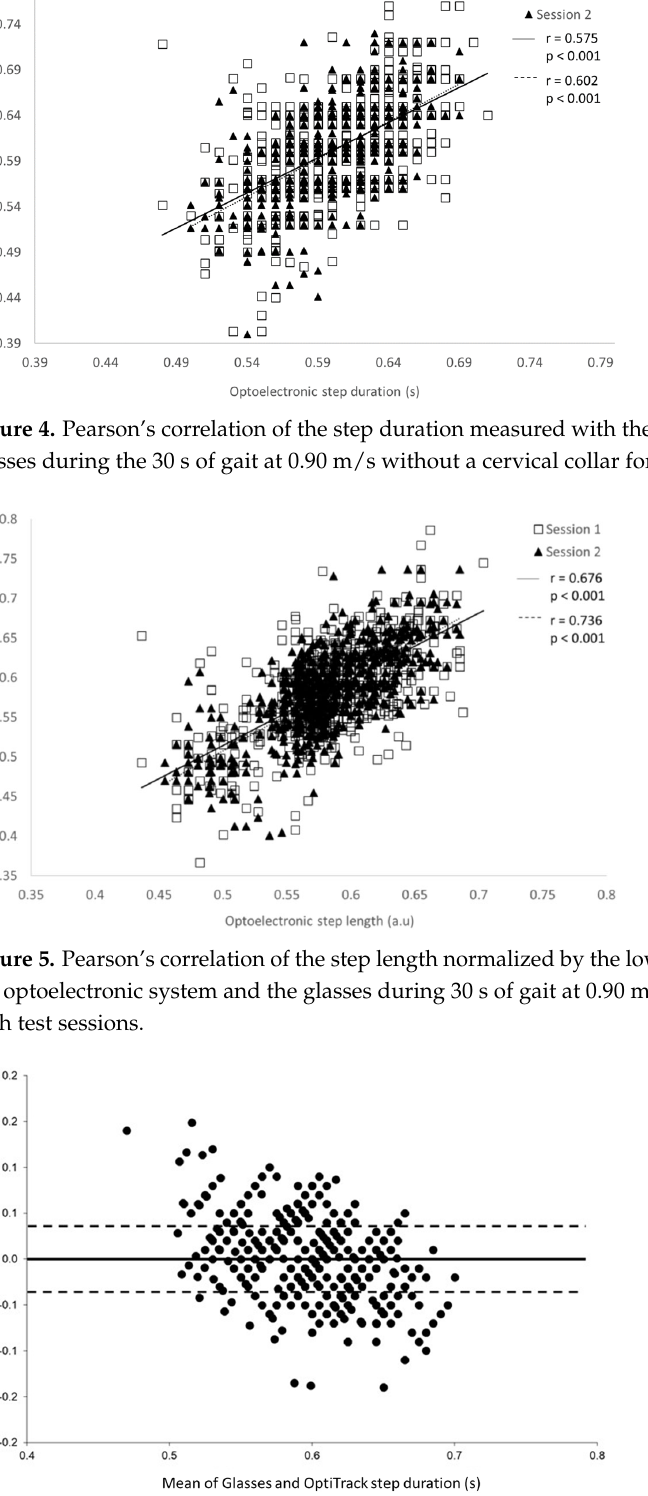
Figure 6. Bland-Altman plots of the step duration recorded without a cervical collar during the Figure 6. Bland ‐ Altman plots of the step duration recorded without a cervical collar during the Figure 6. Bland ‐ Altman plots of the step duration recorded without a cervical collar during the moderate speed condition (i.e., 0.90 m/s) for both testing sessions showing the differences between moderate speed condition (i.e., 0.90 m/s) for both testing sessions showing the differences between Figure 6. Bland ‐ Altman plots of the step duration recorded without a cervical collar during the moderate speed condition (i.e., 0.90 m/s) for both testing sessions showing the differences between the glasses and OptiTrack against the mean of the two systems. The solid horizontal line represents the glasses and OptiTrack against the mean of the two systems. The solid horizontal line represents moderate speed condition (i.e., 0.90 m/s) for both testing sessions showing the differences between the glasses and OptiTrack against the mean of the two systems. The solid horizontal line represents the estimated bias, and the dashed lines represent the 95% limits of agreement. the estimated bias, and the dashed lines represent the 95% limits of the glasses and OptiTrack against the mean of the two systems. The solid horizontal line represents the estimated bias, and the dashed lines represent the 95% limits of agreement. the estimated bias, and the dashed lines represent the 95% limits of agreement.